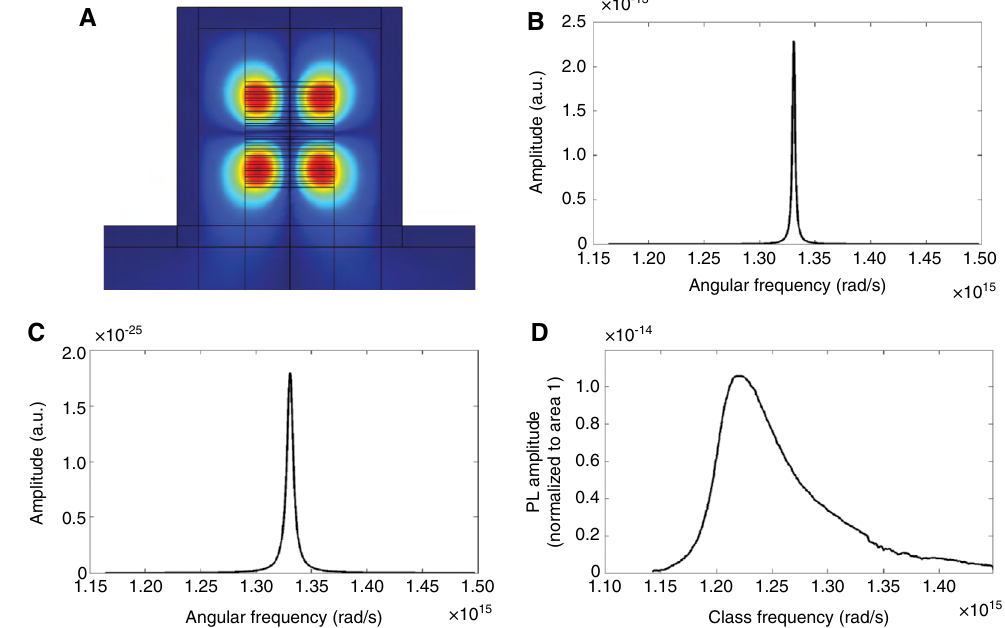
Figure 4 (A) The lasing mode’s electric field profile and the three spectra in the evaluation of the Purcell factor, (B) cavity lineshape, (C) homogeneous broadening lineshape and (D) PL spectrum (Reprinted from